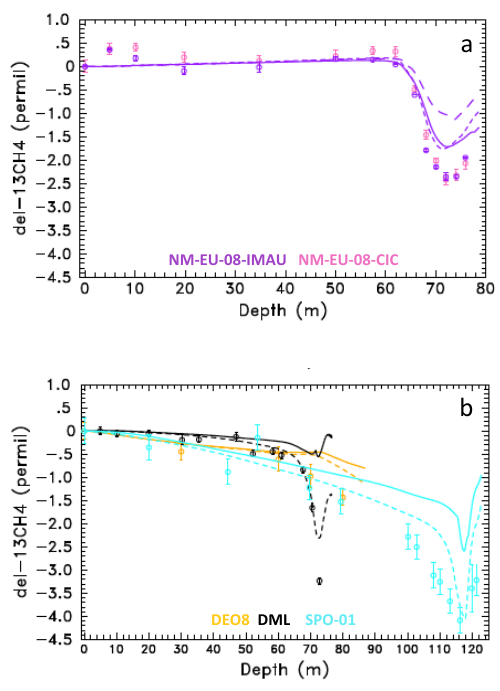
Figure 4: δ 13 C(CH 4 ) firn fractionation calculated with regular (full lines) and modified diffusivities (dashed lines). a: NH sites, NM-­‐EU-­‐08 (purple dots) run with regular diffusivity (full line), with NM-­‐09 diffusivity (short-­‐dashed lines) and with NM-­‐US-­‐08 (long-­‐dashed lines) diffusivity. b: SH sites, SPO-­‐01 (light blue), DML (black) and DEO8 (orange) run with regular diffusivities (full lines) and with modified diffusivity: DEO8 run with DEO8 “slightly modified” diffusivity (see text, orange dashed-­‐line), DML run with δ 13 C(CH 4 ) constrained diffusivity (black dashed-­‐line) and SPO-­‐01 run with SPO-­‐95 (light blue dashed-­‐line).